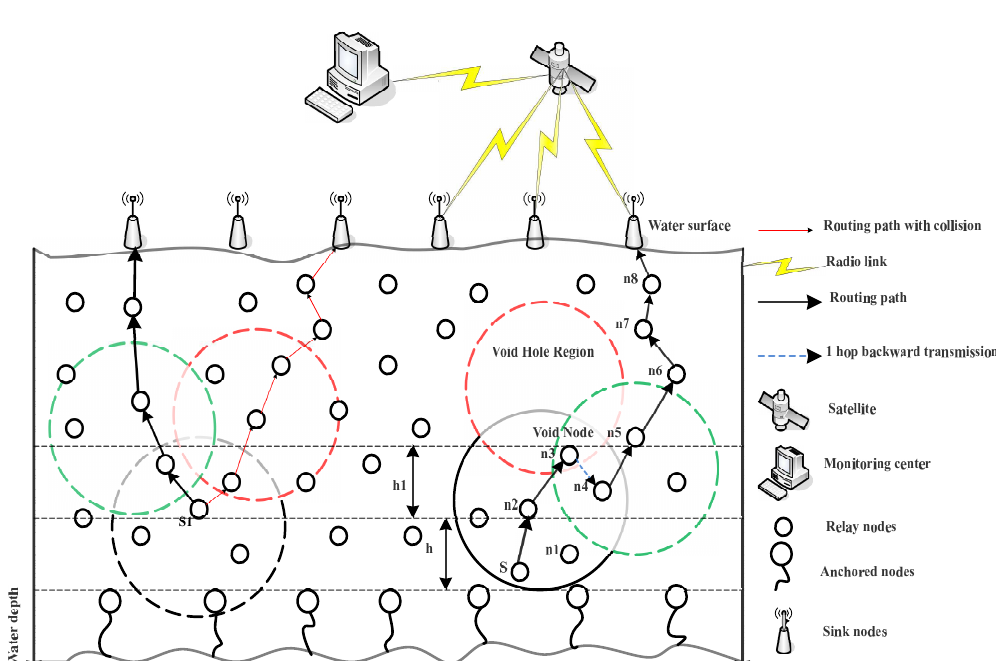
Figure 4. Proposed system model illustrating B-DBR and Collision Avoidance-based (CA)-DBR.